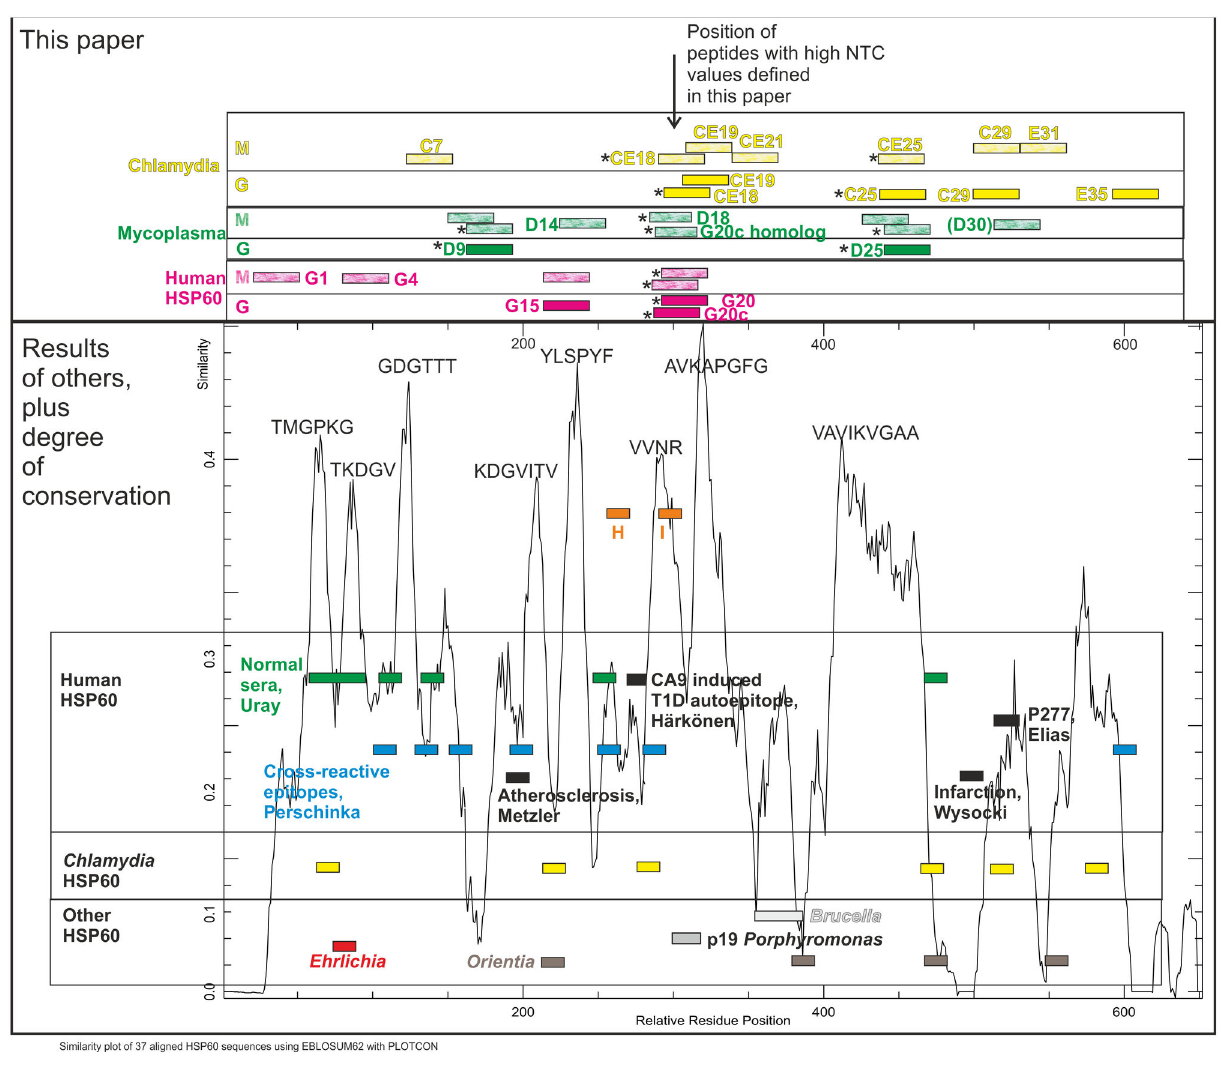
Figure 6. Overview of antigenicities of human, chlamydia and mycoplasma HSP60 peptides from our study, in the context of results from other HSP60 epitope mapping studies. A similarity plot of 34 aligned HSP60 amino acid sequences (Fig. SF4 in file S1) is also included, scoring similarity with the EBLOSUM62 matrix and a sliding window of 10 amino acids, using the program Plotcon (at the EMBOSS web site). Peaks of conservation are labeled with the human HSP60 sequence variant. The X axis shows the position in the alignment. IgG and IgM binding peptides defined in the present paper are shown. Peptides which discriminated ME from non-ME patients and BD (in the Test set) are marked with asterisks. Mycoplasma HSP60 peptides are green, Chlamydia HSP60 peptides are yellow, human HSP60 peptide magenta. Results of others include epitopes recognized by normal human sera (Uray), crossreactive epitopes of human, Chlamydia , E. coli and Mycobacterium HSP60/65 recognized by sera of individuals with atherosclerosis (Perschinka), human HSP60 epitopes (black) selectively recognized in patients with coronary infarction (Wysocki), atherosclerosis (Metzler) and after Coxsackie A9 infection (Härkönen). P277 (Elias) is a human HSP60 peptide containing T and B cell epitopes. It was used in vaccination experiments with NOD mice. Previously reported chlamydia HSP60 epitopes are shown in yellow. A protective and diagnostically useful Ehrlichia peptide (red) and diagnostically useful Orientia tsutsugamushi St58 (dark gray) and Brucella HSP60 peptides (light gray) are also shown. Literature references are given below, and are further discussed in section 6 of File S1. Many of these peptide sequences are also shown in detail in Tables ST1-ST5, and in the alignment of Figure SF4 in file S1.